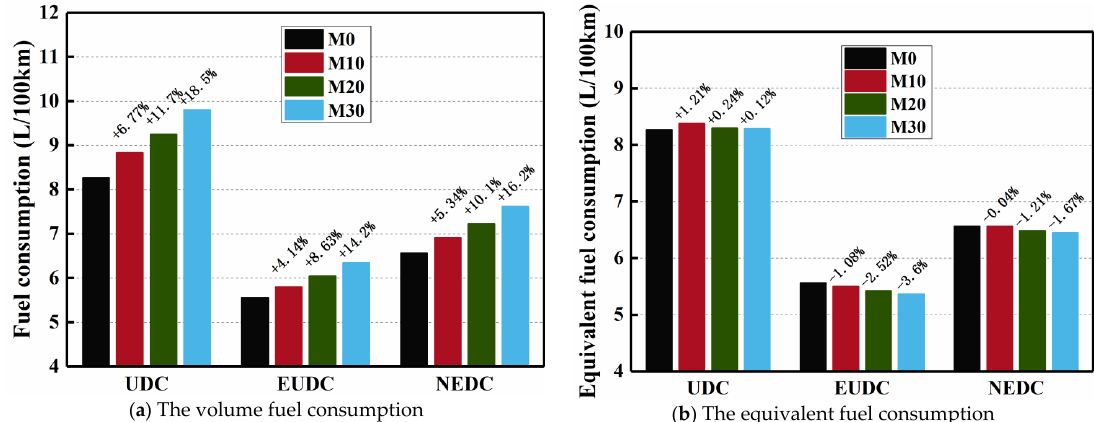
Figure 8. Effects of different methanol blending ratios on fuel consumption under NEDC.